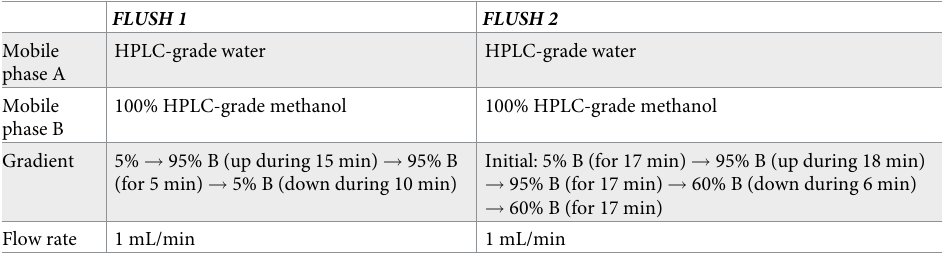
Table 3. HPLC flush methods. These are run at the end of a set number of sample analyses.